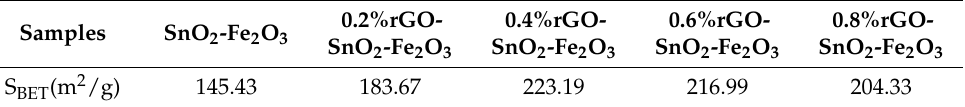
Table 1. Specific surface area of rGO-SnO 2 -Fe 2 O 3 composite oxides.